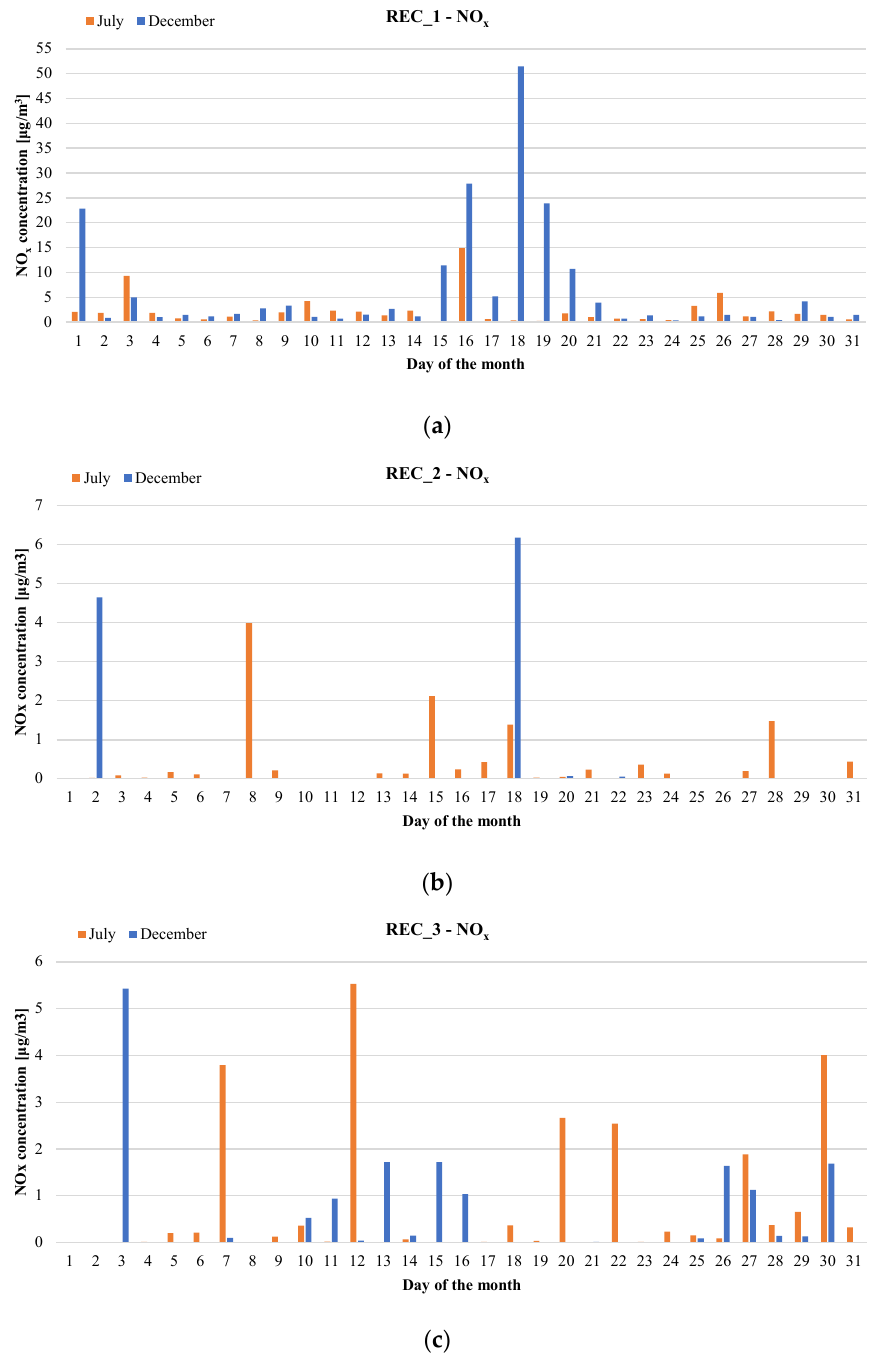
Figure 4. Average 24 h NO x concentrations at ( a ) REC_1, ( b ) REC_2 and ( c ) REC_3 receptors.